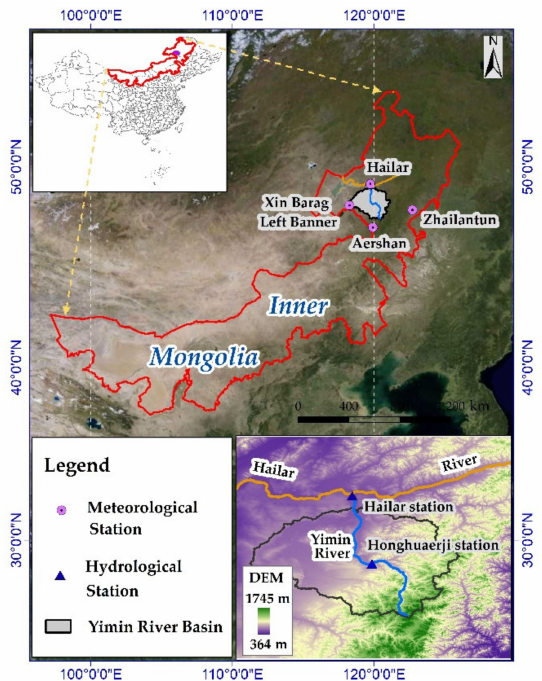
Figure 1. The location of study area, hydrological stations, and meteorological stations in and around the study